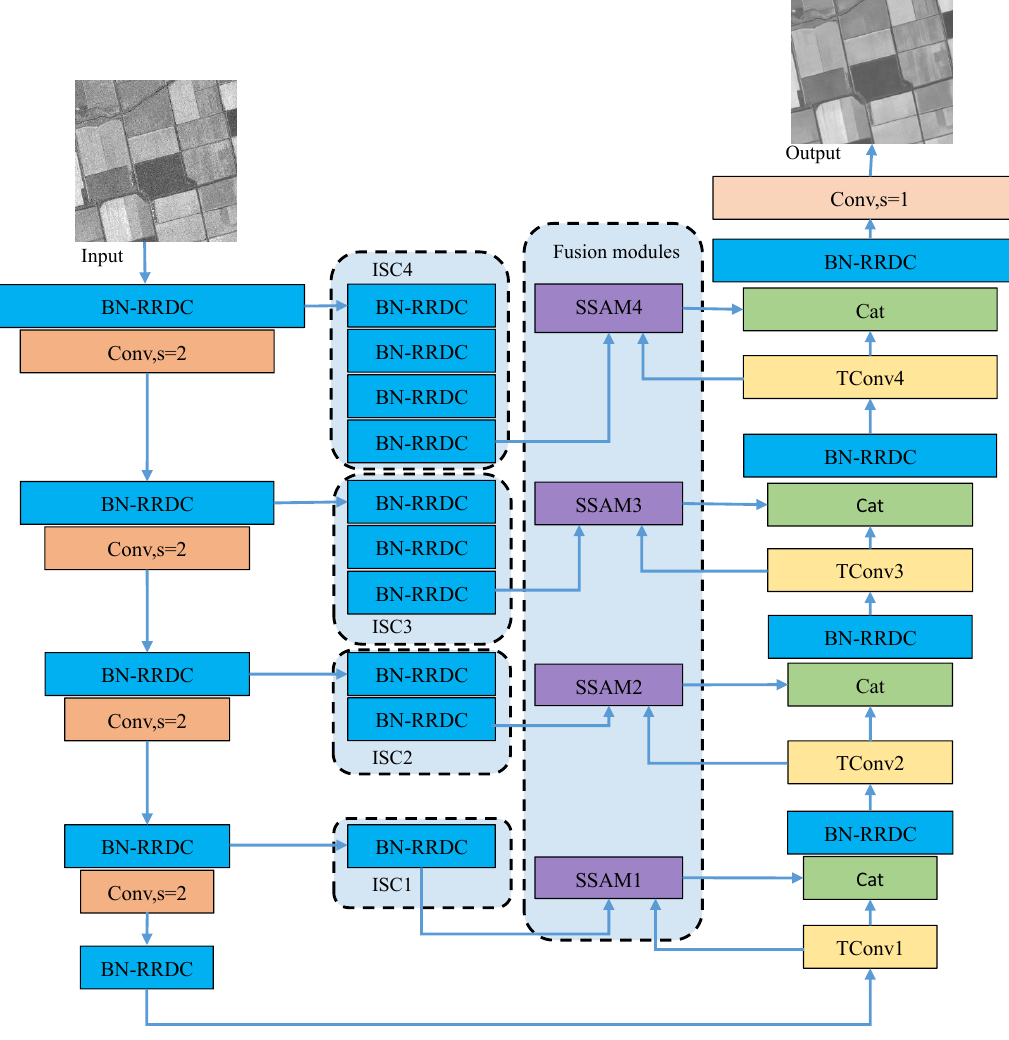
Figure 4. The detailed architecture of